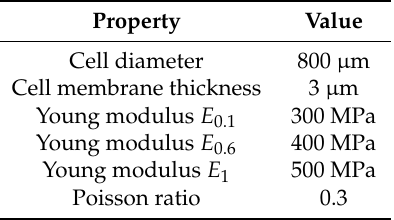
Figure 13. Comparison between experimental and numerical results for different stages of an injection process for injection speed of 0.1 mm/s: ( a ) positioning, ( b – e ) deforming, and ( f ) puncturing. Table 5. Dimensions and properties used in the numerical